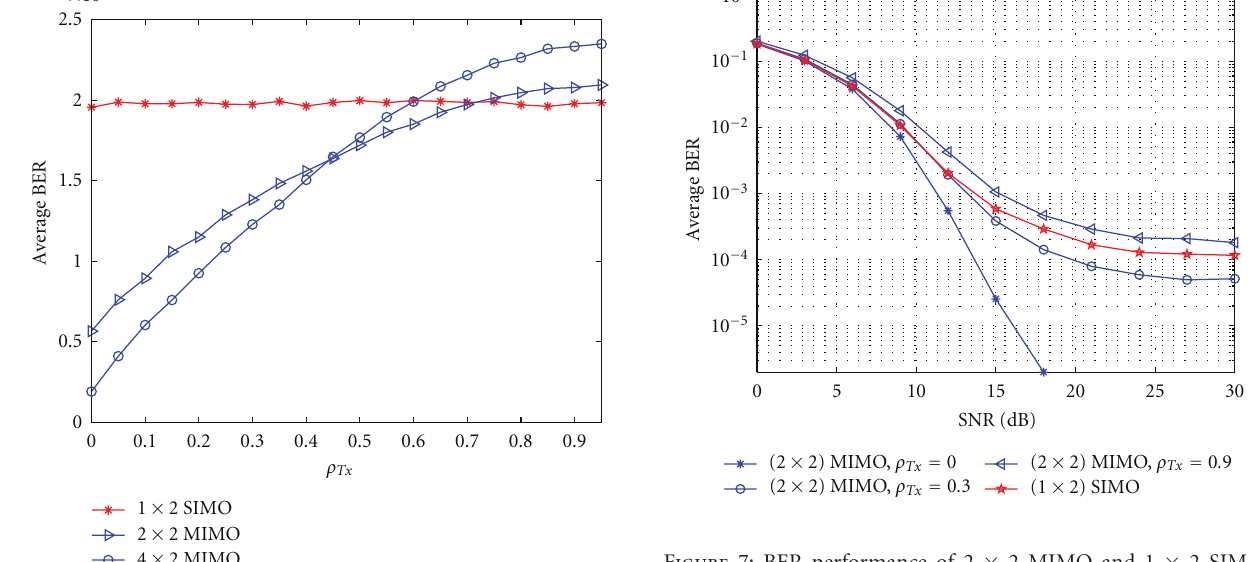
Figure 7: BER performance of 2 × 2 MIMO and 1 × 2 SIMO systems, for CM1 channels.